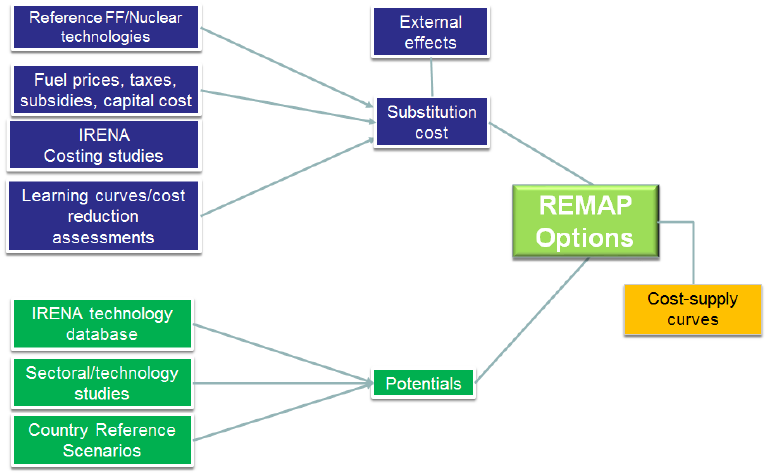
Figure 1. Steps in REmap country analysis and preparation of the roadmap. Source: